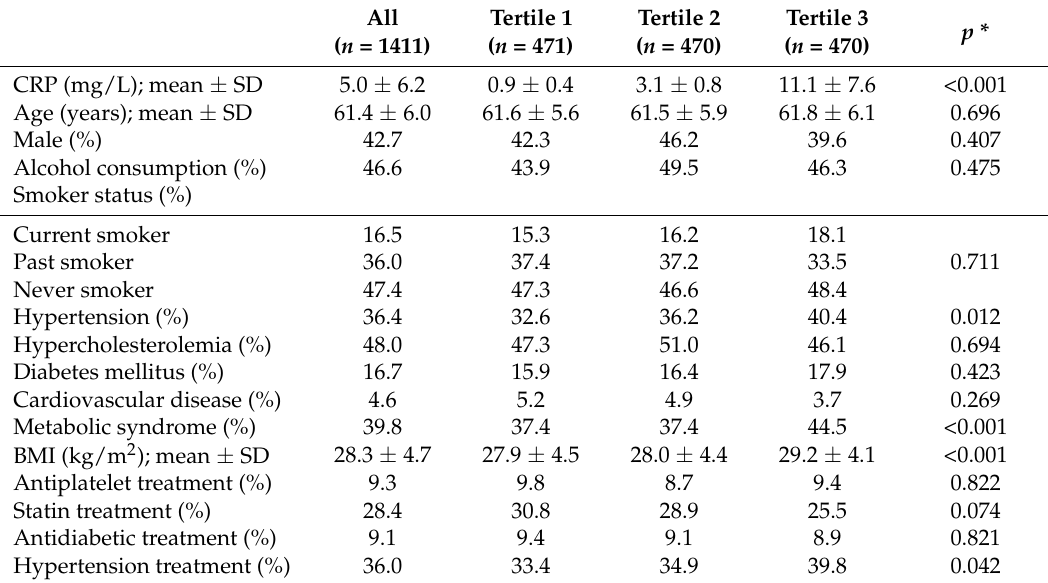
Table 1. Characteristics of the population by C-reactive protein tertiles.